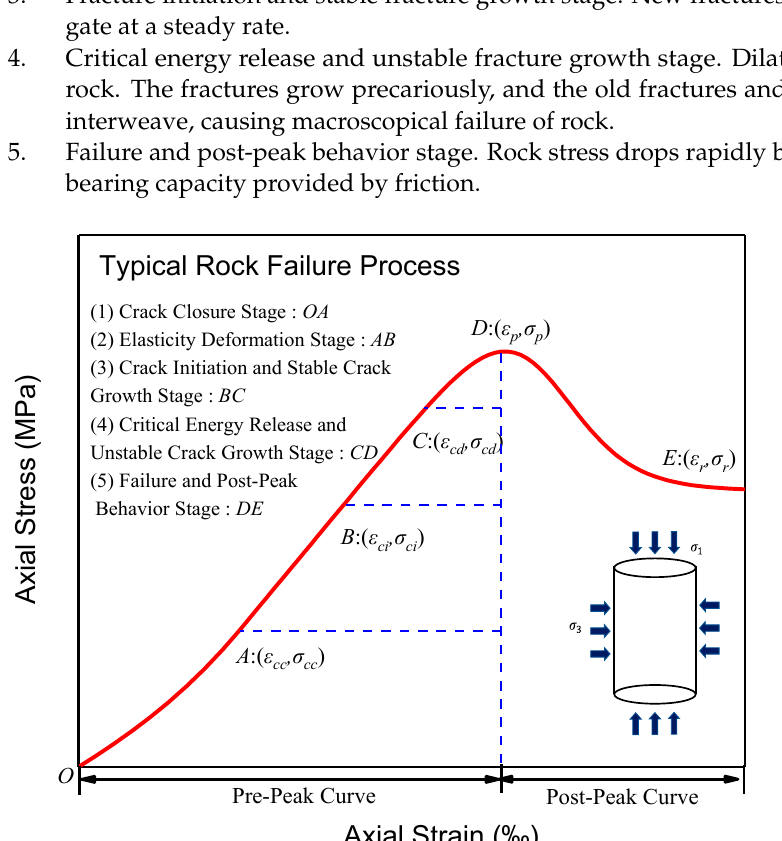
Figure 3. The typical rock failure process.